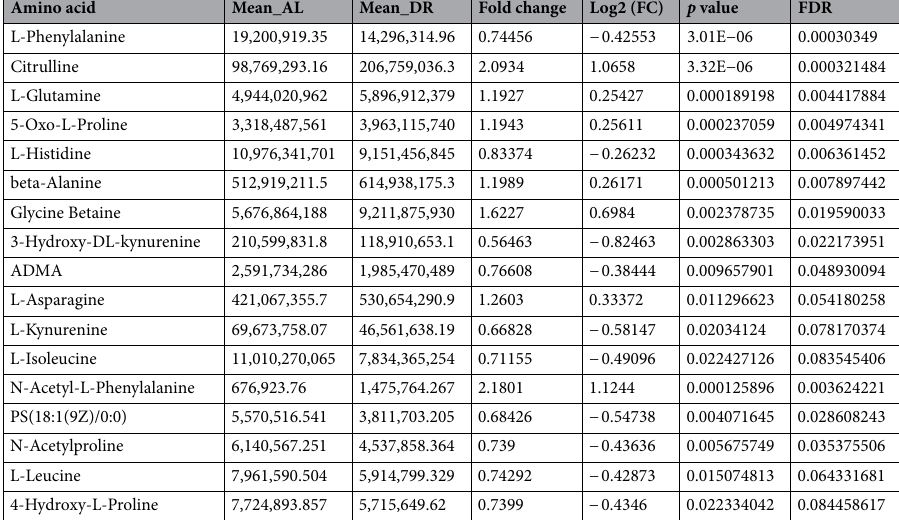
Table 1. J 17 amino acids that level changed significantly in the DR group. FDR false discovery